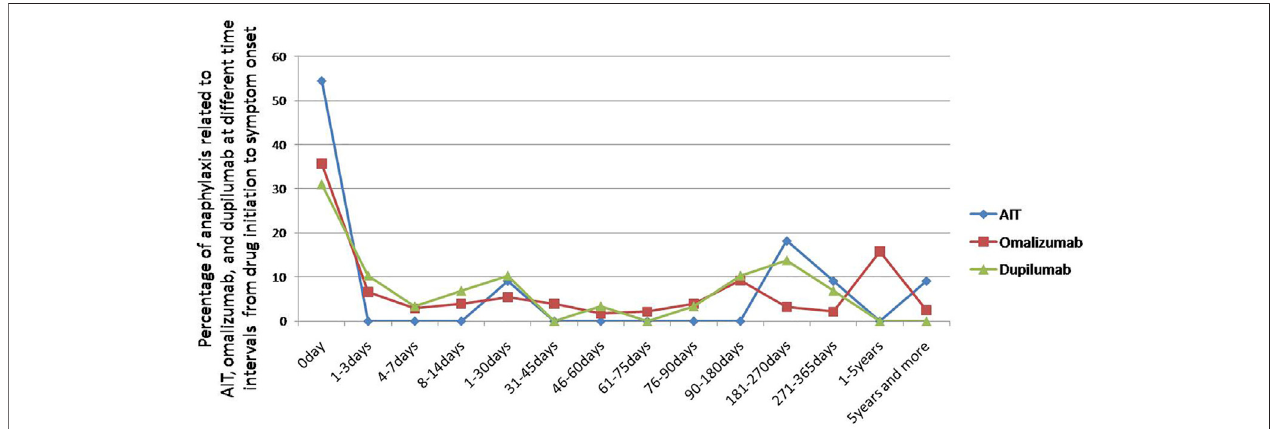
FIGURE 2 | Percentage of anaphylaxis related to AIT, omalizumab, and dupilumab at different time intervals from drug initiation to symptom onset.